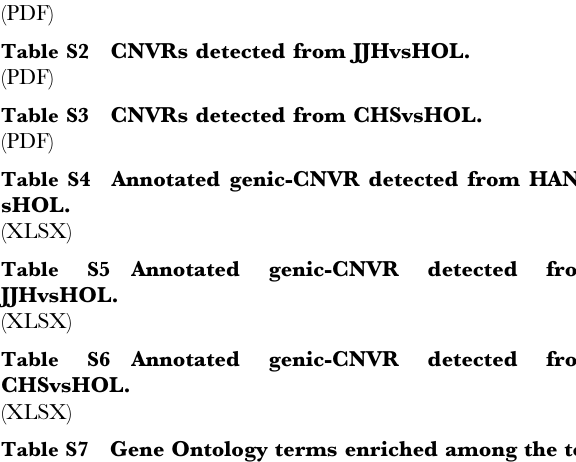
Table S10 Gene Ontology terms enriched among the genic-CNVRs from CHSvsHOL. (PDF) Table S11 The nsSNPs identified in Hanwoo, Jeju Heugu, Chikso, and Korean Holstein that overlap with pigmentation-related genes. TYR, TYRP1, DCT, and MC1R indicate tyrosinase, tyrosinase-related protein 1, dopa- chrome tautomerase, and melanocortin 1 receptor respectively. (PDF) Table S12 Regions of homozygosity (ROHs) detected from Hanwoo, Jeju Heugu, Chikso, and Korean Holstein in this study.